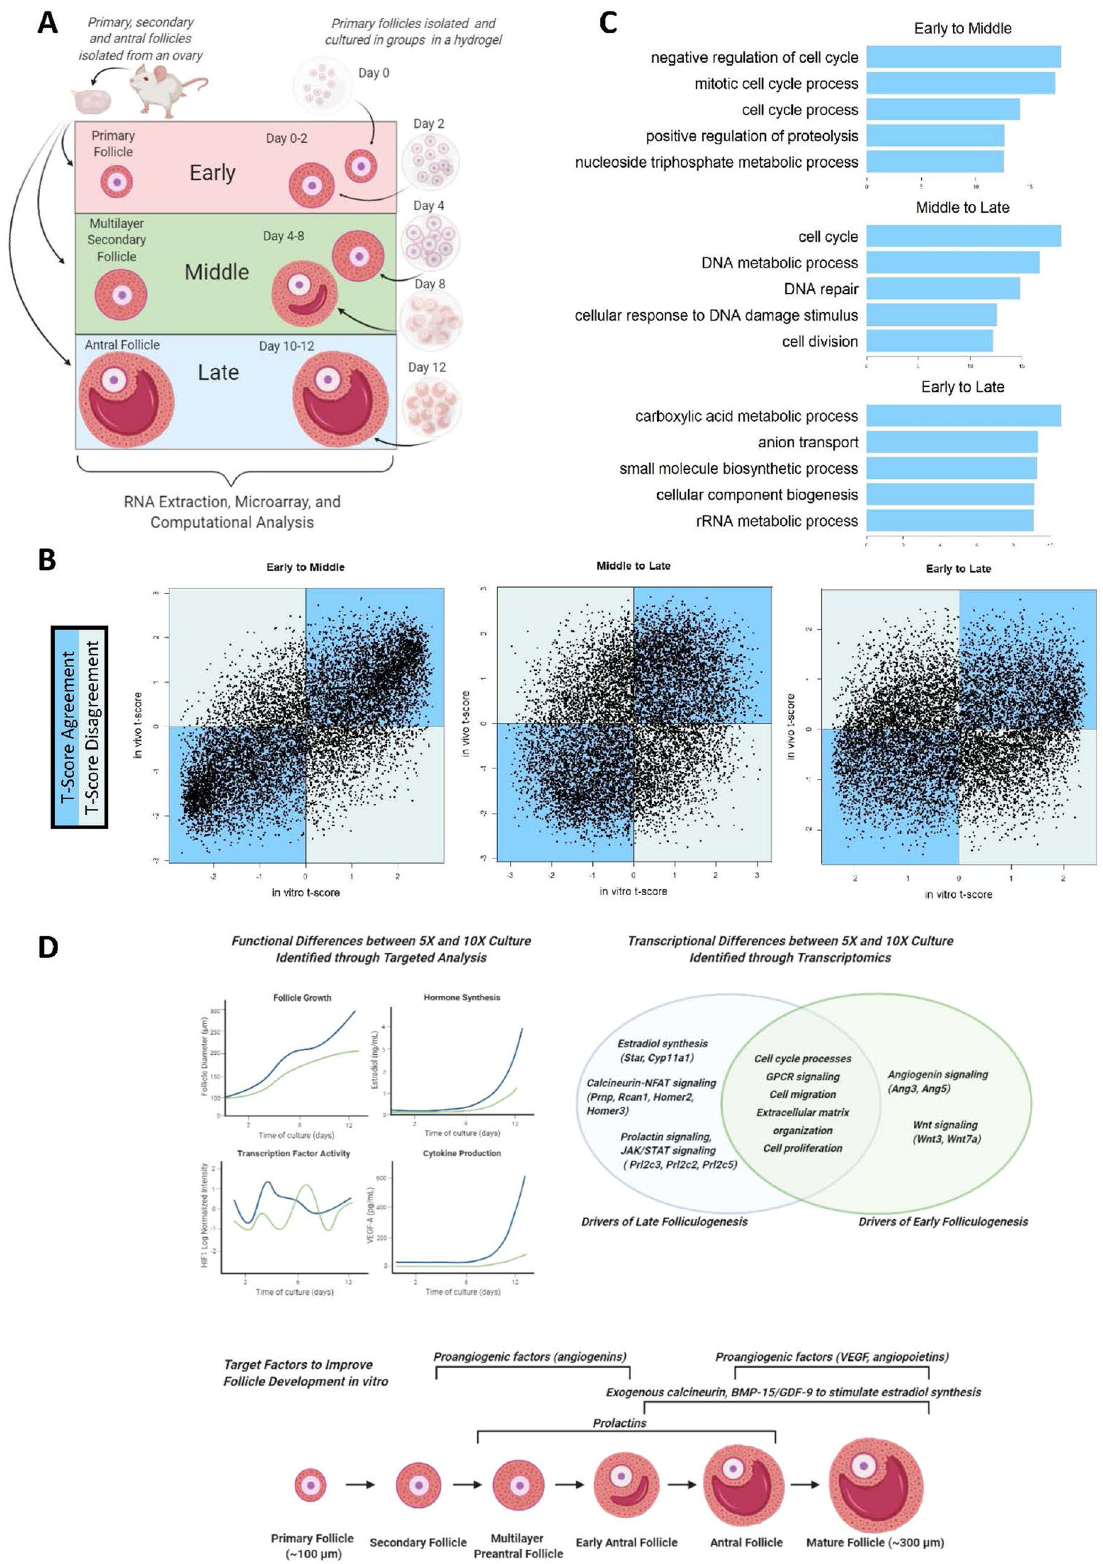
Figure 4. Ovarian follicles developing in vitro, compared to those developing in vivo, show significant transcriptional similarities and differences. ( A ) Schematic explaining methods for comparing in vivo dataset to 5X and 10X dataset, ( B ) t-score agreement plots (r = 0.704, 0.345, and 0.212 respectively), ( C ) top GO terms from GOrilla analysis, highlighting GO terms from the gene lists with shared t-scores signs between in vitro and in vivo, and ( D ) summary of study findings: previously described targeted analyses from Zhou et al. 2018, combined with transcriptome analysis, leads to identification of targets for improving in vitro follicle culture. ( A ) was generated using Biorender (biorender.com). ( B ) and ( C ) were generated using R (version 3.6.9, https:// www.r- proje ct. org/) 55